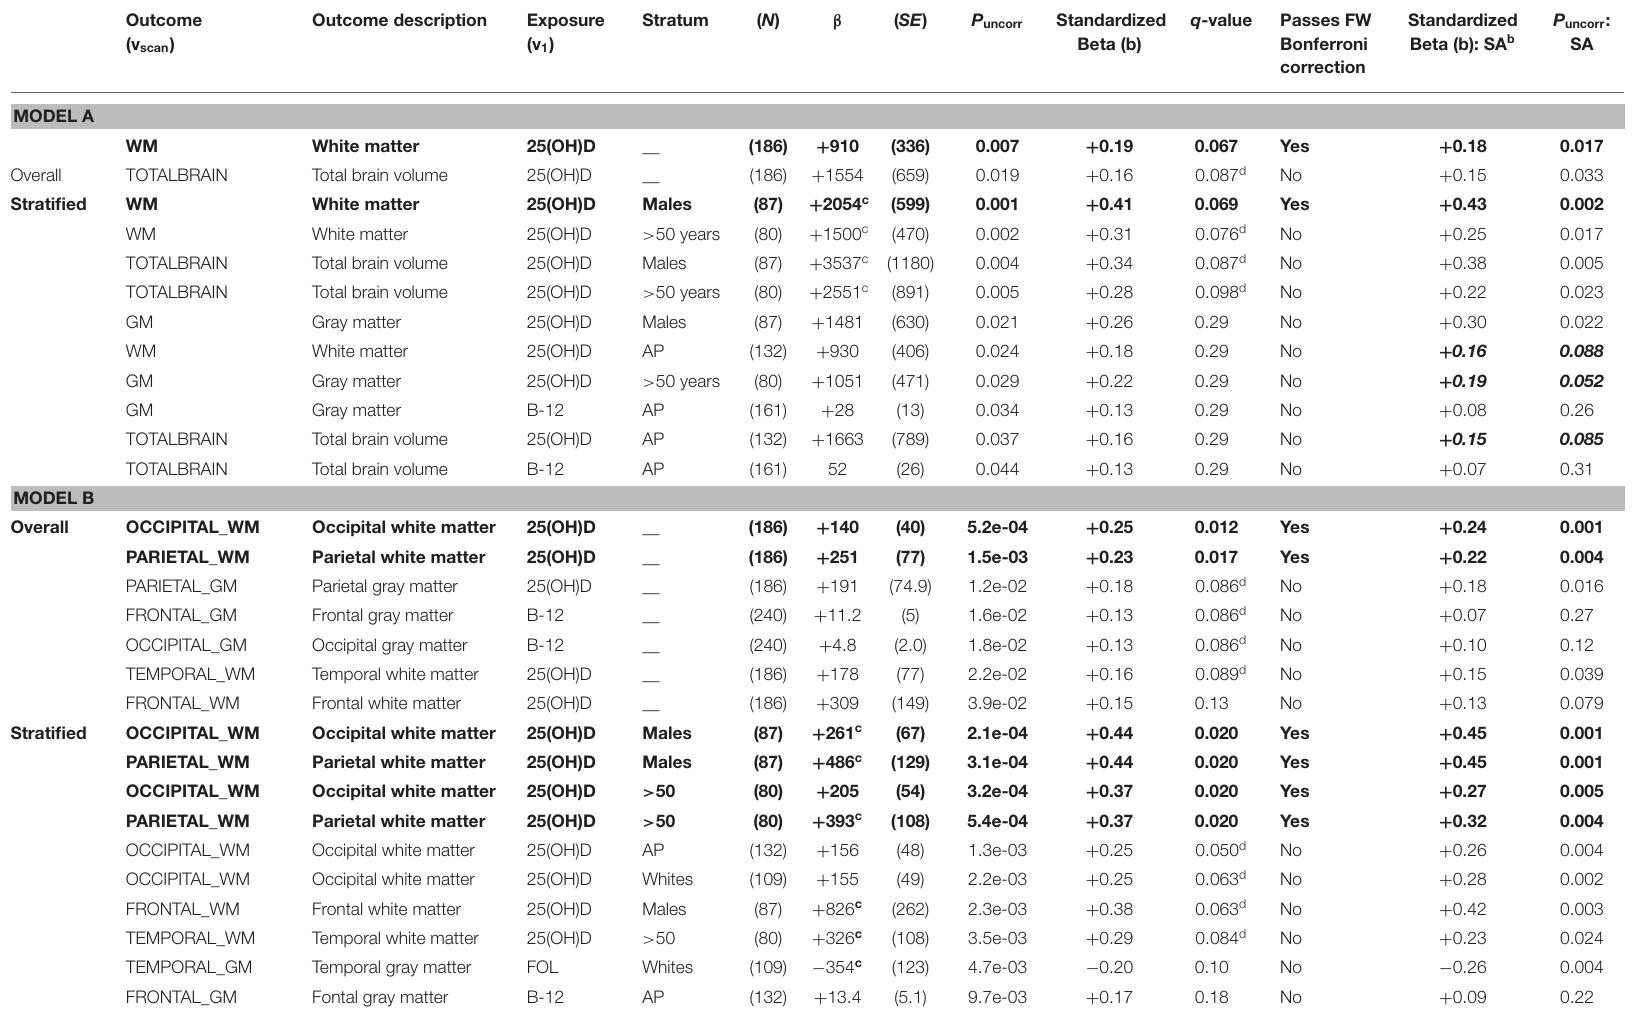
TABLE 2 | Top 10 adjusted associations from models A (total, GM, WM) and B (regional GM, WM) vs. visit 1 exposures: serum 25(OH)D, folate and cobalamin (overall and stratified analysis) with uncorrected P < 0.05: ordinary least square brain scan-wide analyses on HANDLS 2004–2009 and HANDLS-SCAN 2011–2015 a .